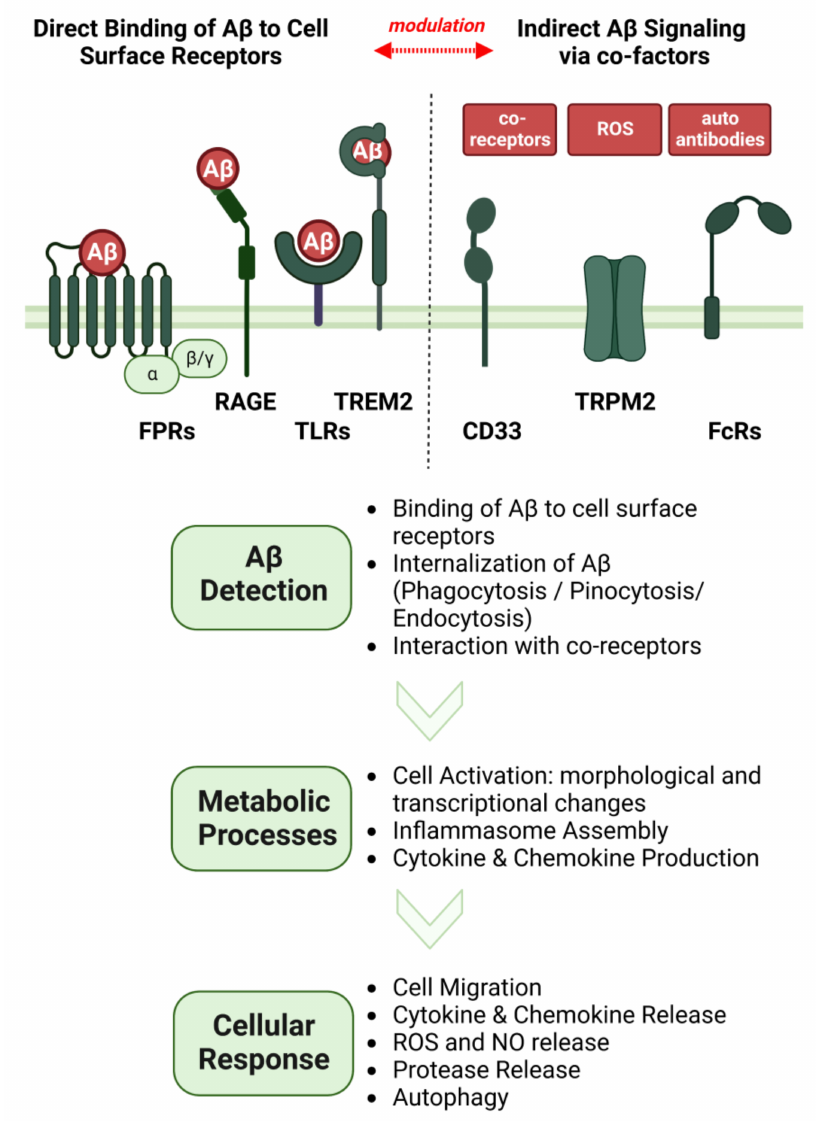
Figure 5. A β -mediated activation of microglia. Direct detection of A β (e.g., by TREM2, TLRs, FPRs, RAGE) or indirect stimulation through A β -mediated processes (e.g., TRPM2 activation by ROS, detection of autoantibodies against A β by FcRs) leads microglia to adopt their reactive phenotype in which they utilize intracellular signaling pathways and metabolic processes to initiate their pro- inflammatory